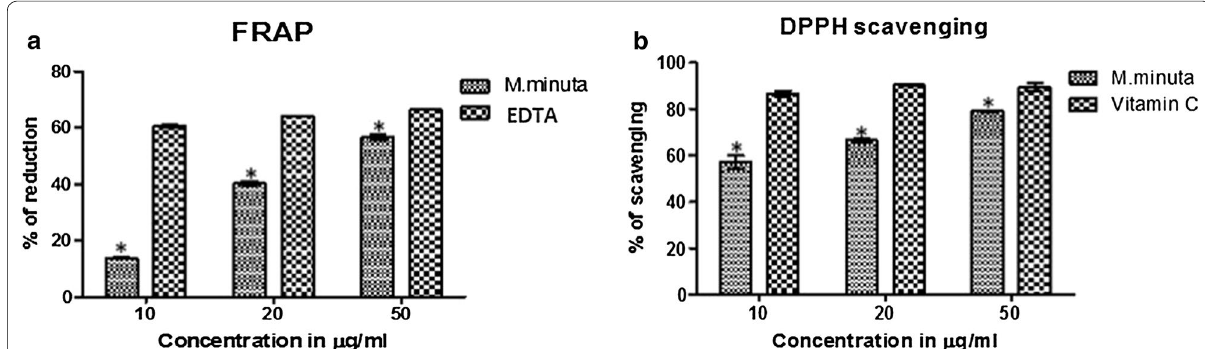
Fig. 1 a FRAP scavenging activity of M. minuta leaves extract (%), b percentage inhibition of DPPH free radical by M. minuta leaves extract. Values represent the mean SEM of triplicate, independent experiments; the values labeled with Asterisk indicate statistically significant difference ± compared with standard compound as determined by Student t-test (p < 0.05)